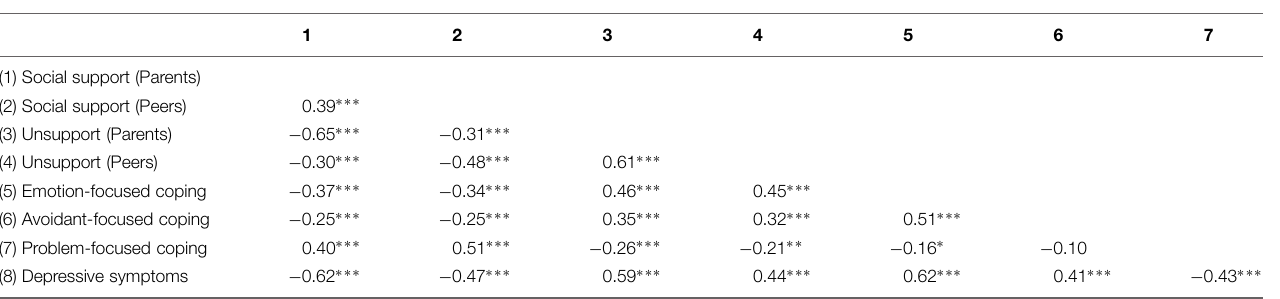
TABLE 3 | Relations between depressive symptoms, social support, unsupport, and